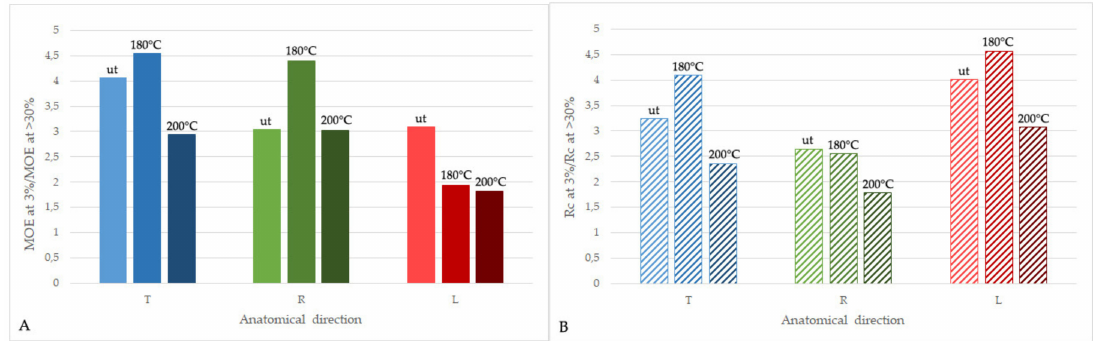
Figure 4. Anisotropy of the ratio between MOE ( A ) and R c ( B ) values at MC of 3% and > 30% for untreated (ut) and thermally-modified ash (at 180 and 200 ◦ C) in the tangential (T), radial (R), and longitudinal (L)